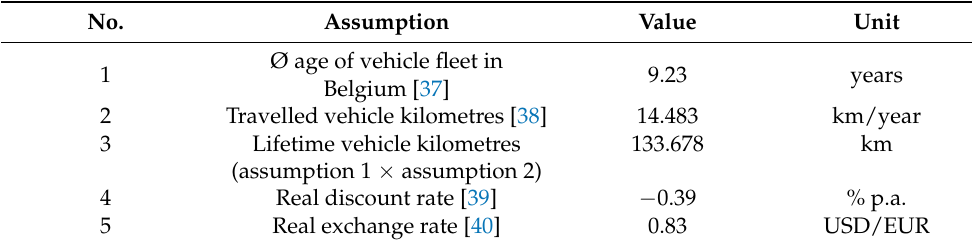
Table 6. Overview of the general assumptions